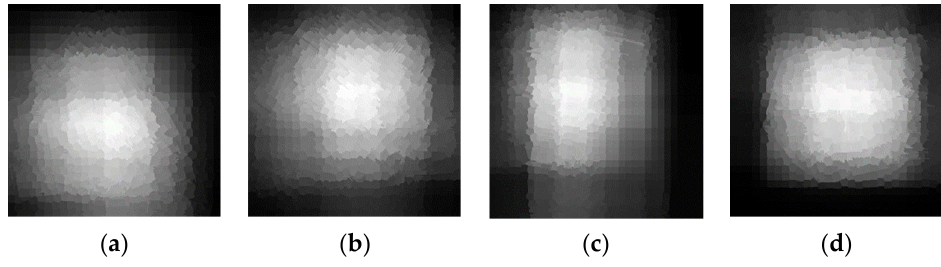
Figure 11. Foreground mask maps. ( a ) Image I, ( b ) Image II, ( c ) Image III, ( d ) Image IV.